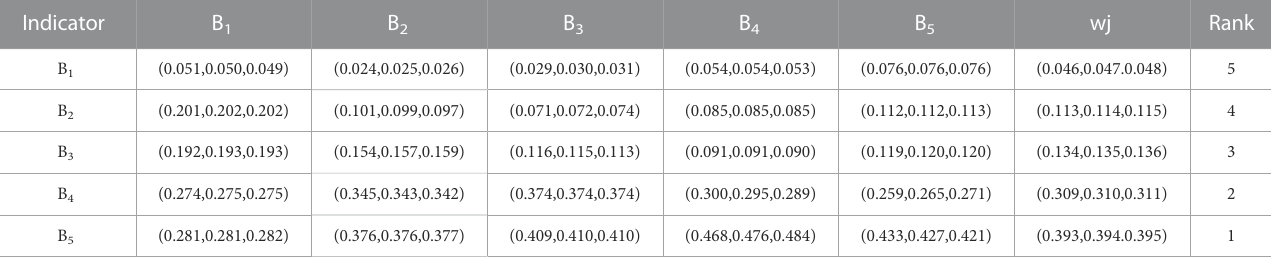
TABLE 11 Standard weight and ranking of civil construction factor layer (MCS-AHP).